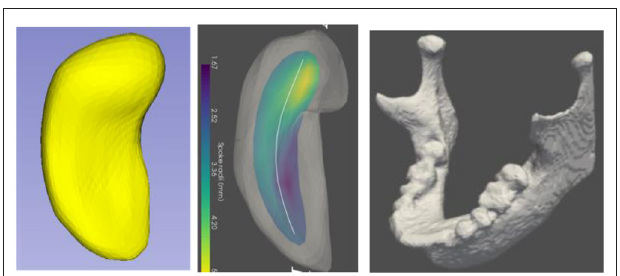
FIGURE 2 | An ellipsoid’s skeleton sampled into a grid and its spokes; spokes at the skeletal fold are displayed as red, those on the north side of the skeleton in cyan, and those on the south side in magenta. The spine is bold, and the center point is displayed as a bullet. Since all slabular objects have a central curve, formed by the spine, and cross-sections, they can all be understood